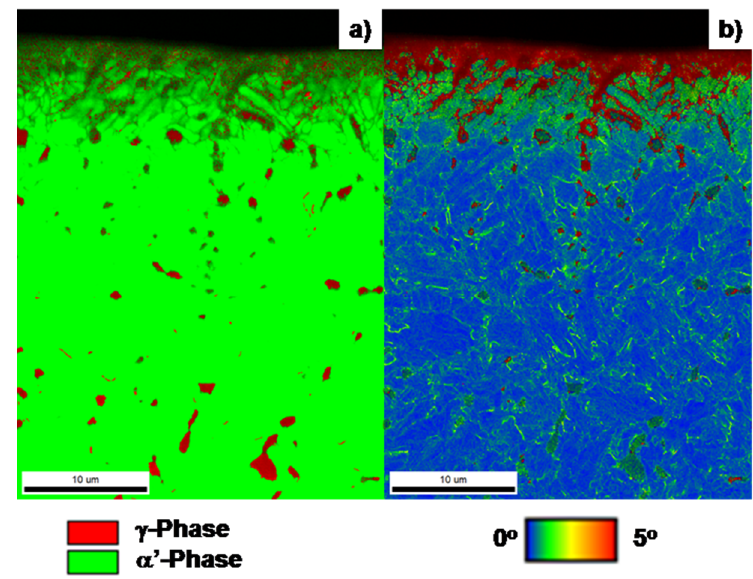
Figure 6. Phase mapping and kernel average misorientation (KAM) distribution on the cross-section of Figure. 6 . Phase mapping and kernel average misorientation (KAM) distribution on the nitrided AISI420 at 673 K for 3.6 ks; ( a ) phase mapping; ( b ) KAM cross-section of nitrided AISI420 at 673K for 3.6 ks; a ) phase mapping; b ) KAM distribution.